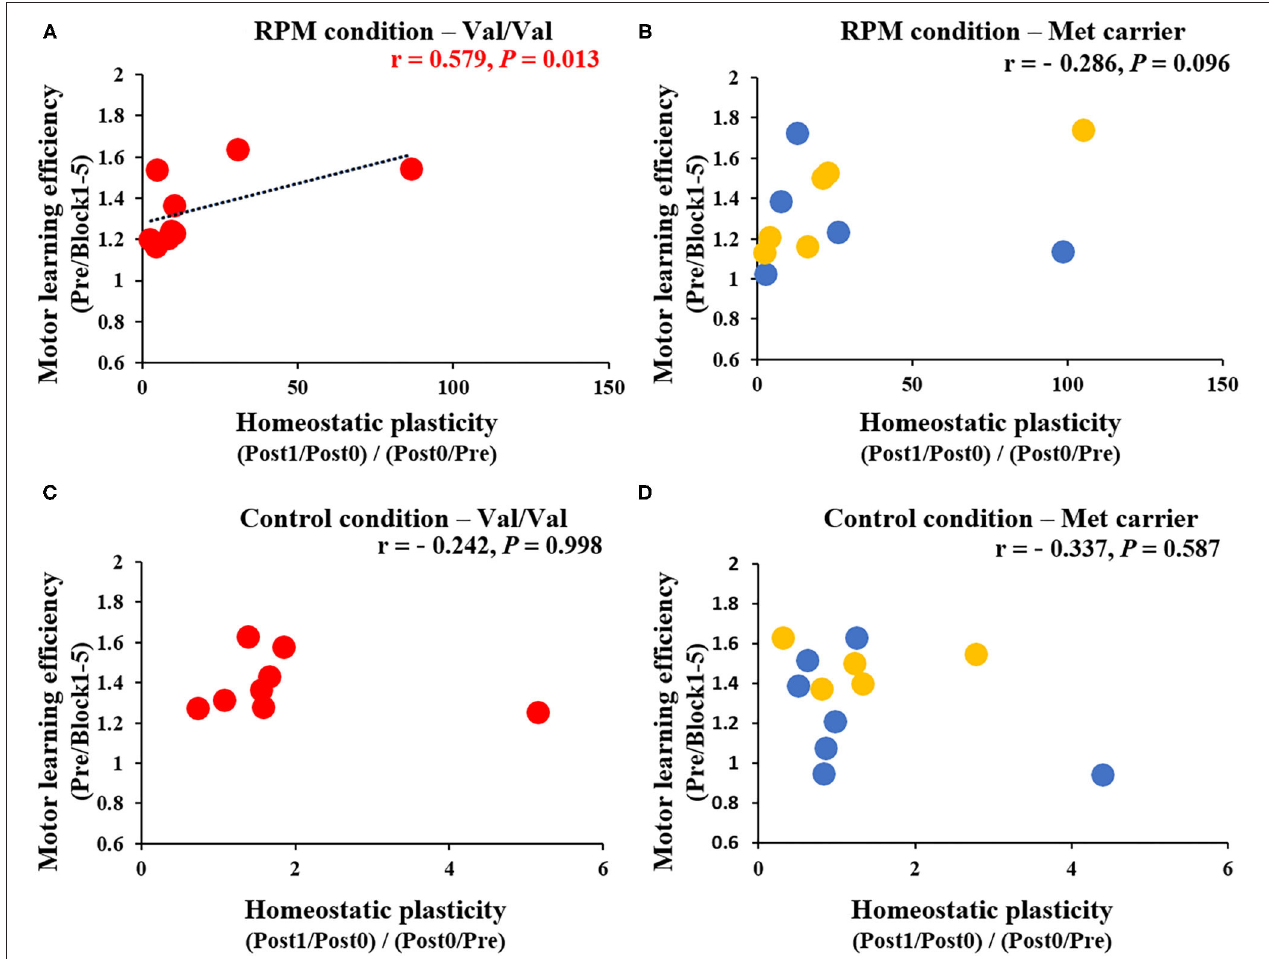
FIGURE 8 | (A–D) Correlation between homeostatic plasticity and motor learning efficiency for each genetic polymorphism. The red circles are the Val/Val, the blue circles are the Val/Met, and the yellow circles are the Met/Met genotypes. A significant correlation between homeostatic plasticity and motor learning efficiency was found for the Val/Val genotype in the RPM condition alone ( r = 0.579; P = 0.013). These results suggest that in carriers of the Val/Val genotype, the motor learning rate was more likely to be higher in subjects who exhibited homeostatic-plasticity-like plastic changes in the RPM